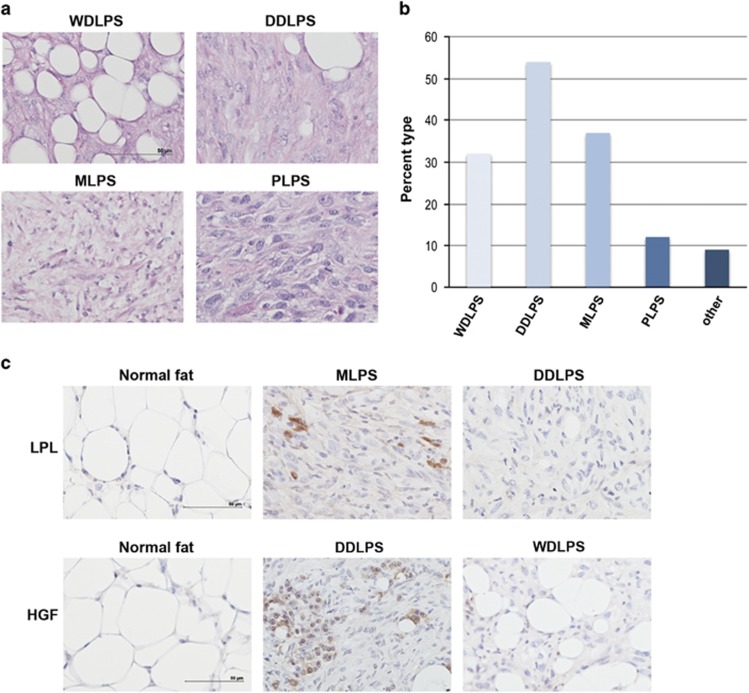
Classification of liposarcomas generated in the Ptenflox/flox; p53flox/flox mouse model. (a) Representative hematoxylin and eosin (H&E) of the four major subtypes of liposarcoma identified; well-differentiated liposarcoma (WDPLS), dedifferentiated liposarcoma (DDLPS), myxoid liposarcoma (MPLS) and pleomorphic liposarcoma (PLPS). (b) Bar diagram graph represents the percentage of the each of the subtypes of liposarcoma. A small percentage of other subtypes of sarcomas were identified, including rhabdomyosarcoma and osteosarcoma. (c) Different subtypes of liposarcoma are characterized by a unique lipocytic phenotype. Lipoprotein lipase (LPL) is an adipocytic marker and stains more mature adipocytic sarcomas such as WDLPS and MLPS. Hepatocyte growth factor (HGF) is a mesenchymal stem cell marker and stains immature liposarcomas such as DDLPS and PLPS. Scale bar corresponds to 50 μm